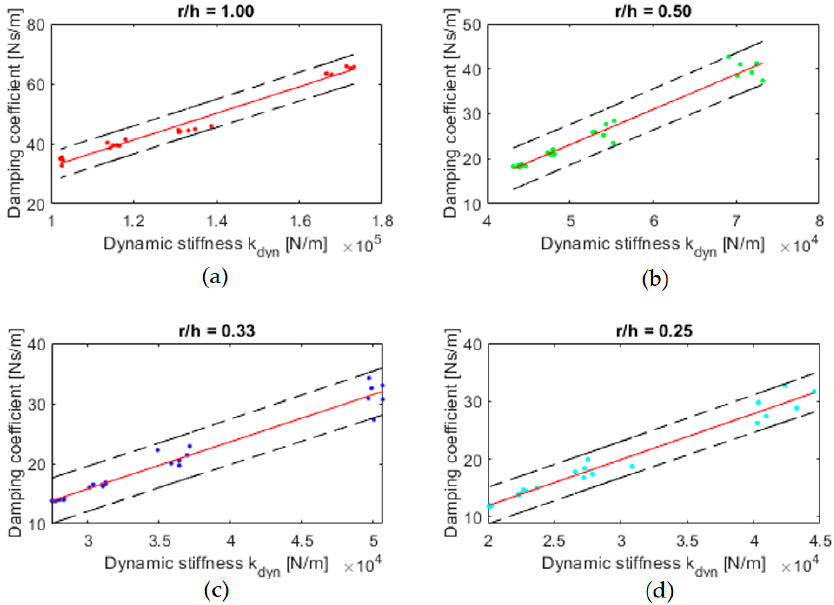
Figure 16. Presentation of linear fitting (function a x + b ) for dynamic stiffness and damping coefficient: ( a ) r/h = 1.00 (red dot), ( b ) r/h = 0.50 (green dot), ( c ) r/h = 0.33 (blue dot), ( d ) r/h = 0.25 (cyan dot). Red lines are considered as best fitting curve and black dashed lines are confidence interval limits. Coe ffi cients of linear fi tt ing and R-square are presented in Table 8. Table 8. Coefficients of linear fit for function a x + b with 95% confidence bounds for Figure